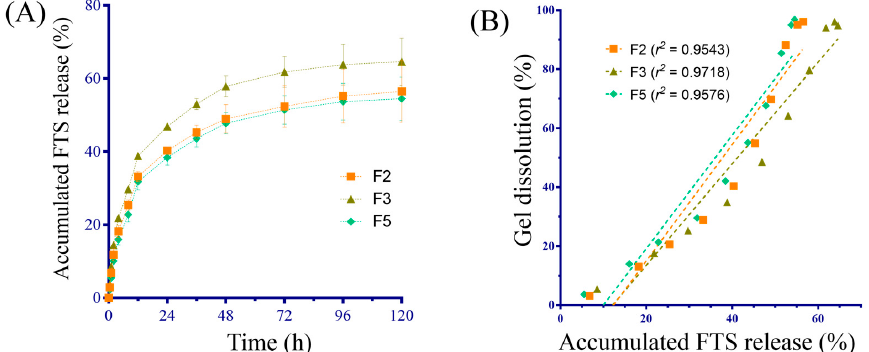
Figure 3. ( A ) The accumulative drug release rate of F2, F3 and F5 ( n = 3); ( B ) Correlation profile of the accumulative percent of FTS released and the accumulative percent of thermo-sensitive hydrogel dissolved ( n = 3 for each formulation).